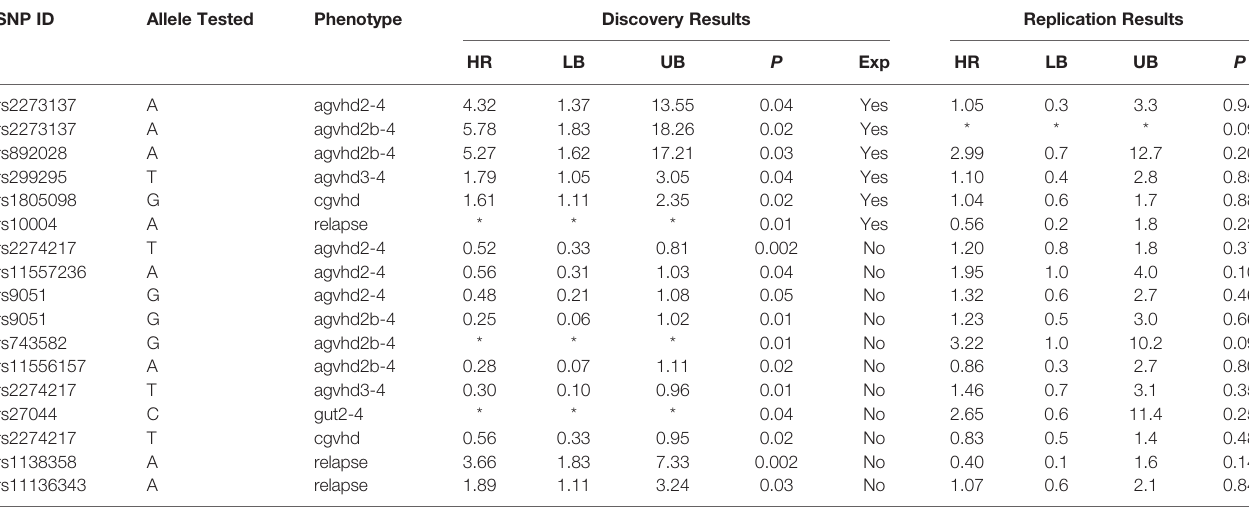
TABLE 3 | Known HLA-A*02:01 minor histocompatibility antigens prespeci fi ed for replication testing. SNP ID